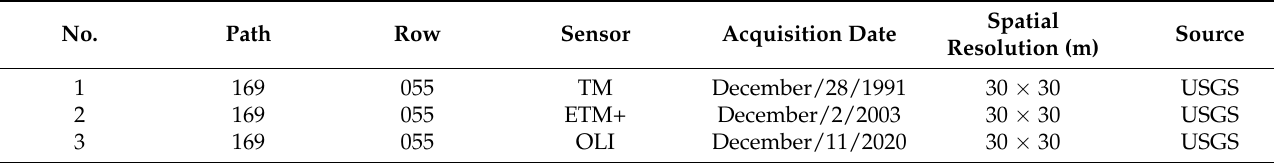
Table 1. Satellite image used in this study